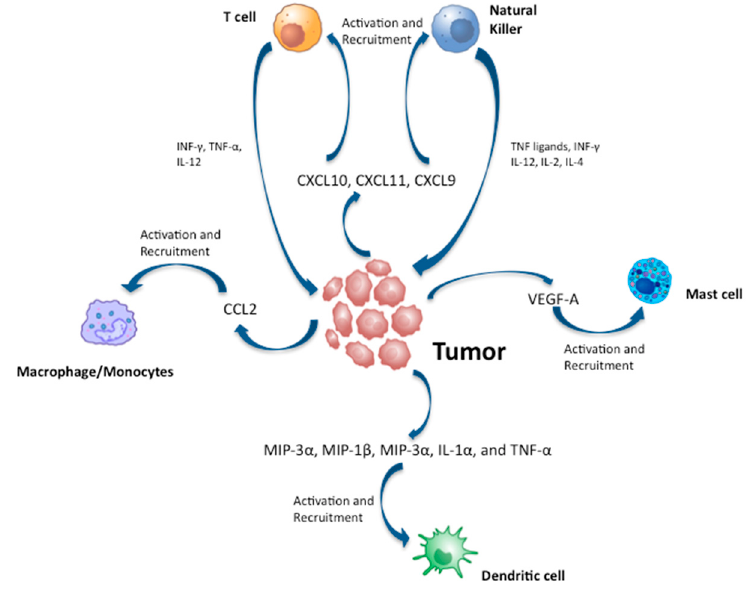
Figure 3. Cytokines and chemokines released in thyroid cancer microenvironment and their role in recruiting inflammatory cells.